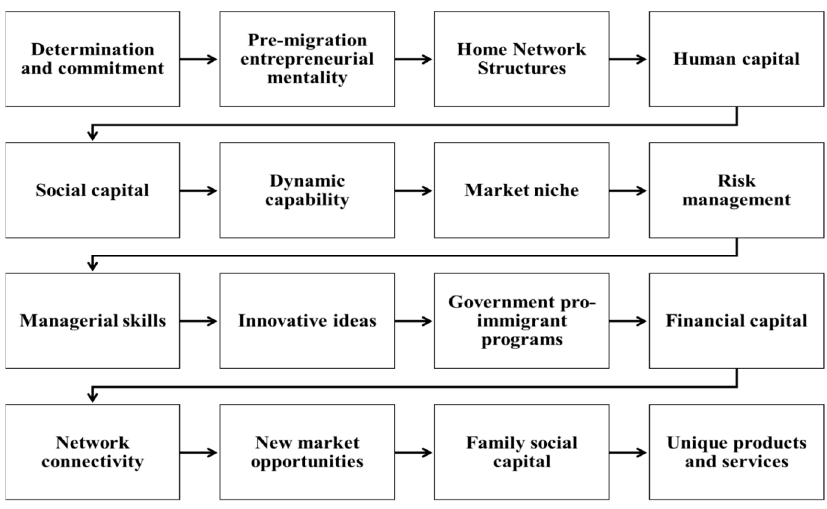
Figure 3. Sixteen Entrepreneurship Strategies. Source: Authors’ own